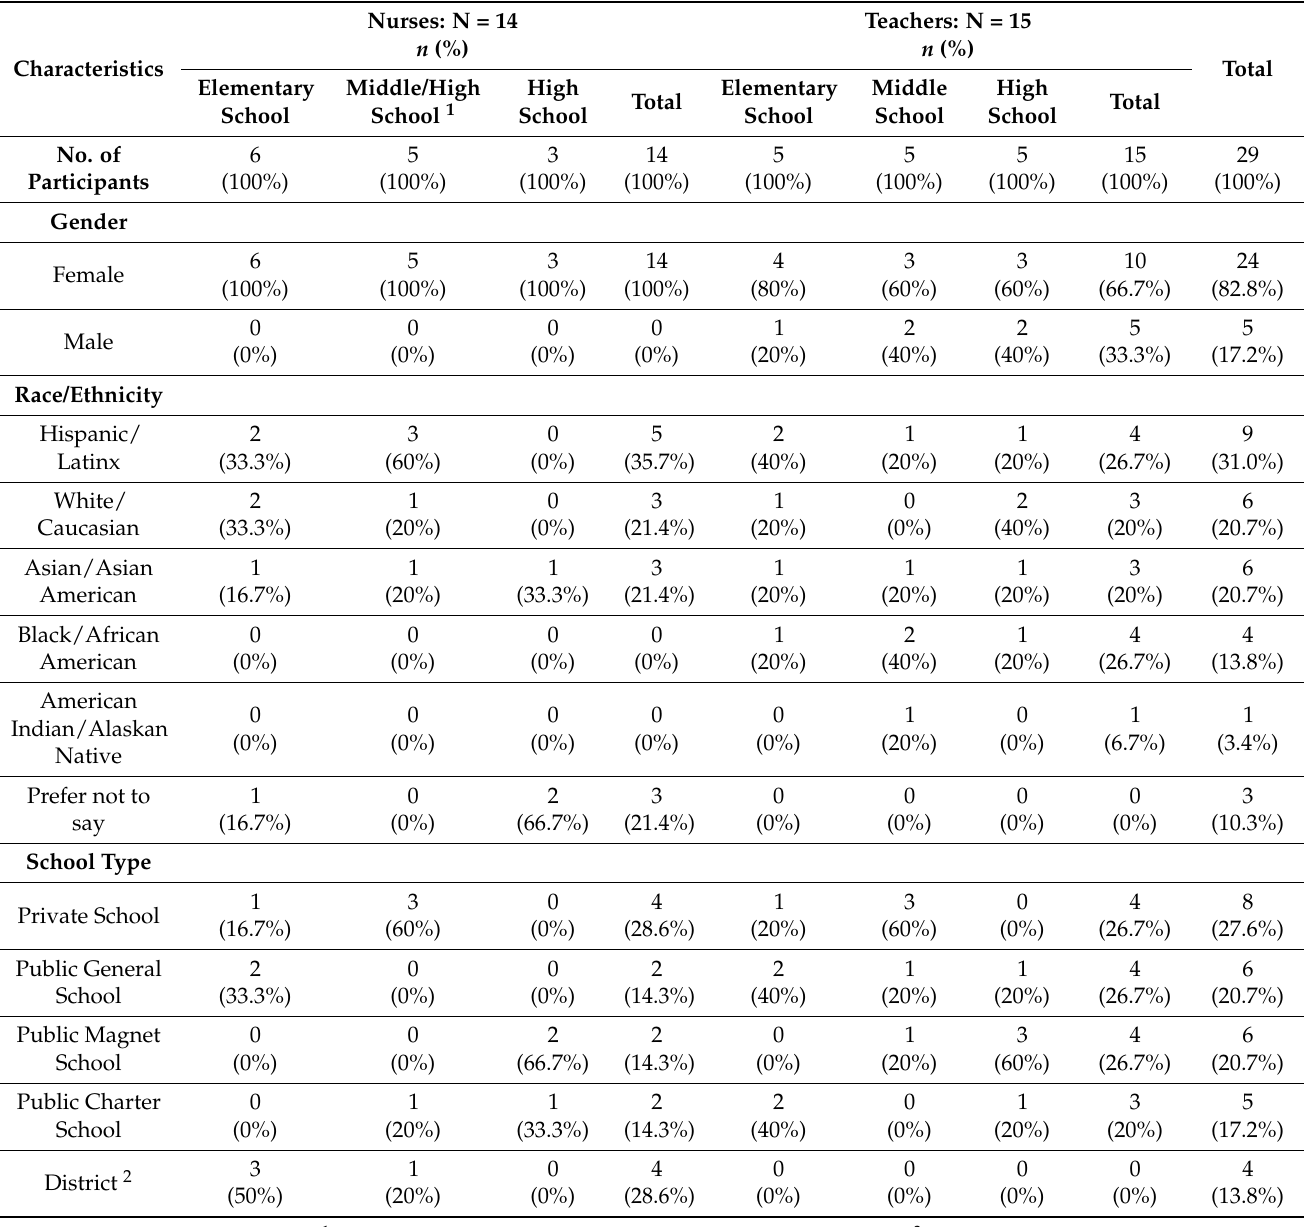
Table 1. Characteristics of nurses and teachers by